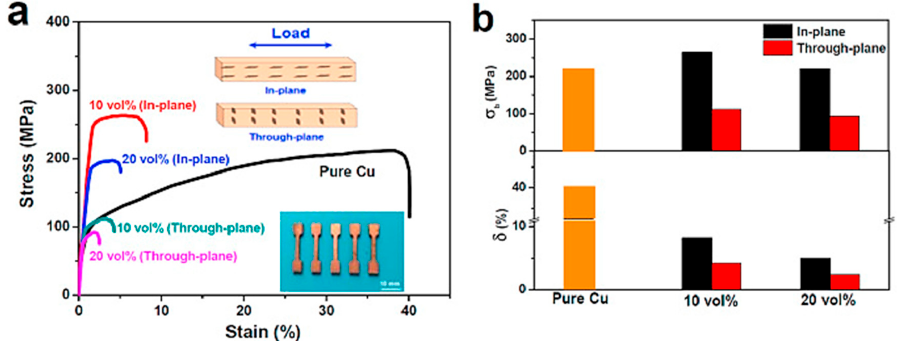
Figure 16. ( a ) Tensile stress-strain curves and ( b ) obtained properties of tensile strength ( σ b ) and elongation ( δ ) for pure Cu and 10 vol %/20 vol % GNP/Cu composites with the load parallel and perpendicular to the alignment direction [144], Reproduced from [144], with permission from Elsevier, 2018.